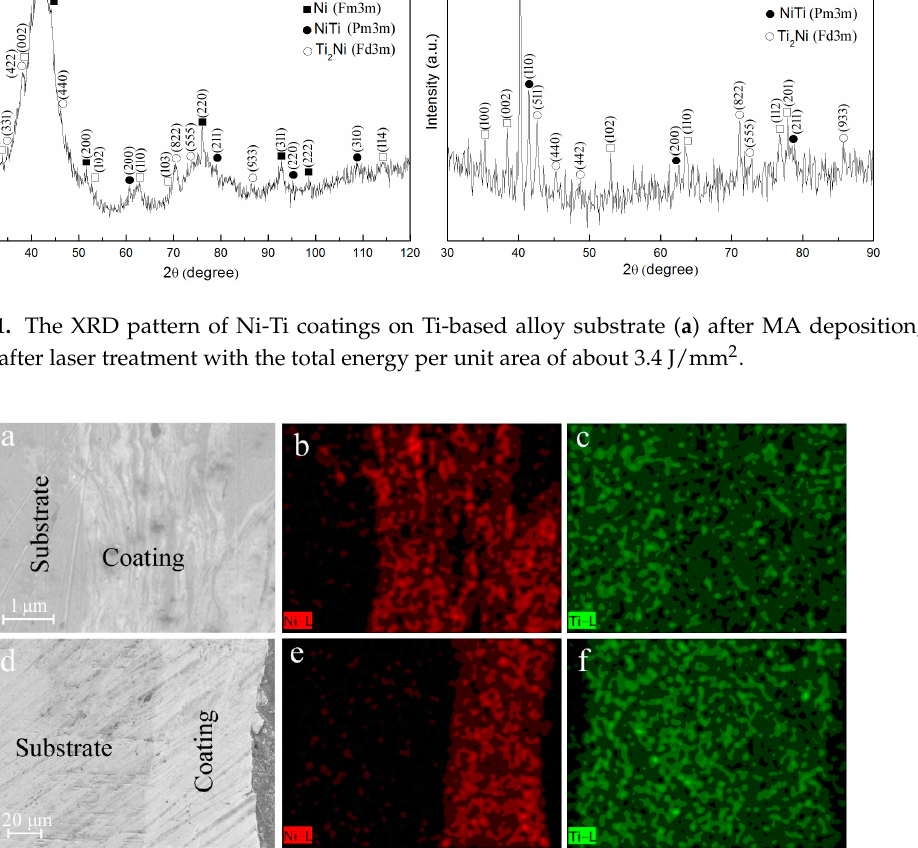
Figure 2. Cross-section SEM images and element mapping of the Ni-Ti coatings on the Ti-based alloy substrate after MA: ( a ) a general view of the microstructure; ( b ) contents of Ni; ( c ) Ti. Cross-section SEM images, and element mapping of the Ni-Ti coatings on the Ti substrates after MA and subsequent laser treatment with the total energy of 3.4 J/mm 2 : ( d ) a general view of the structure; ( e ) contents of Ni; ( f ) Ti.